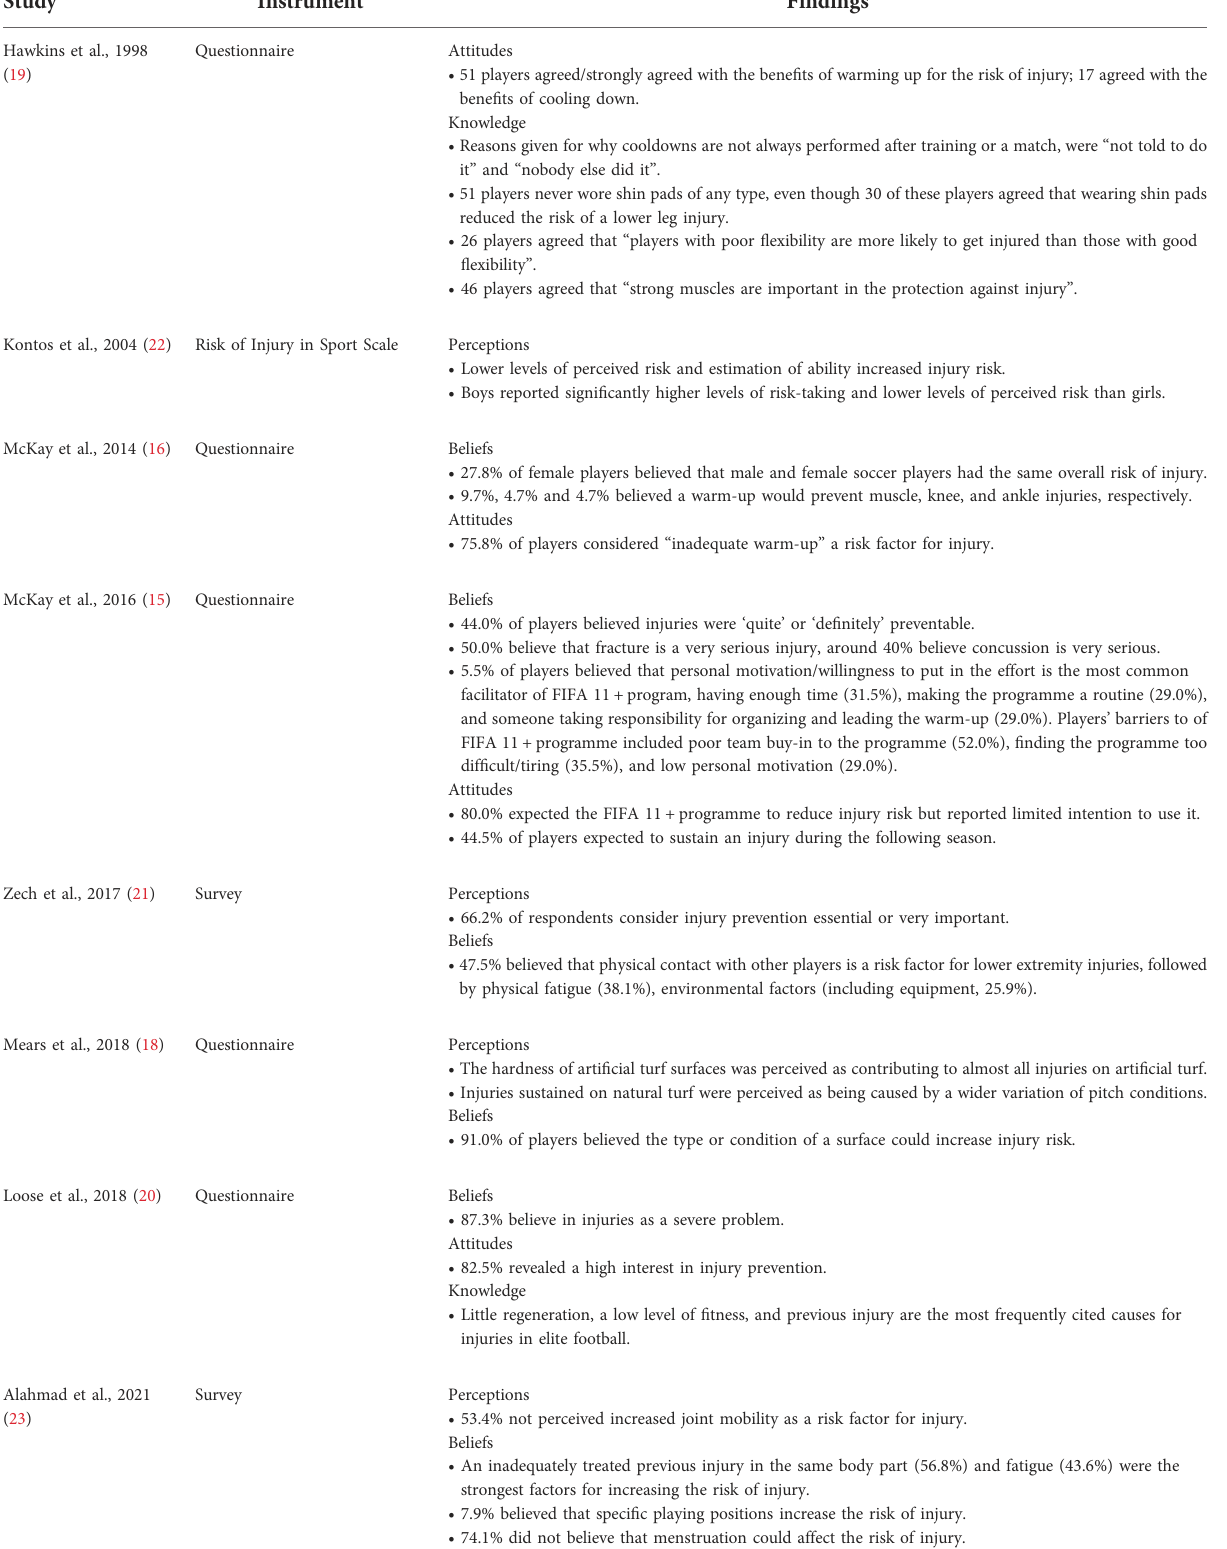
TABLE 2 Findings of included